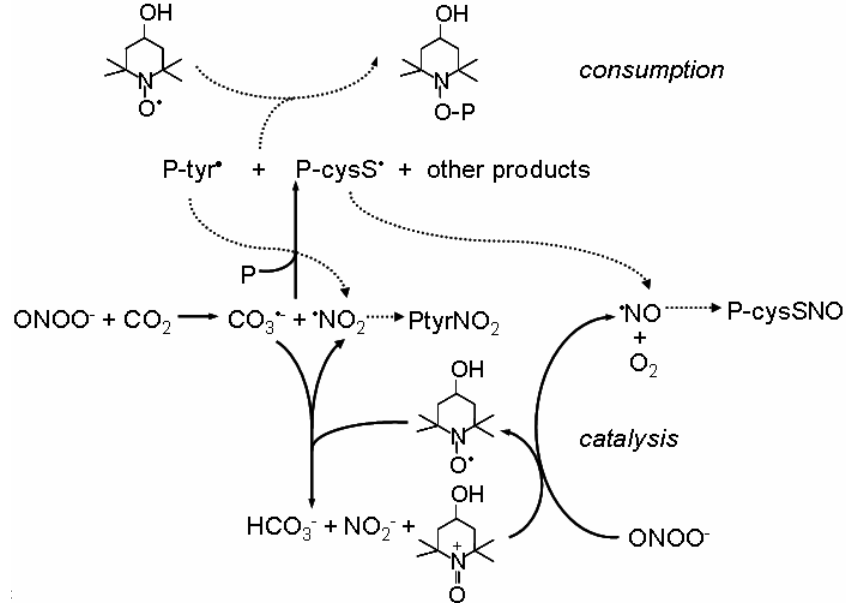
Fig. 2 – Schematic representation of the mechanism by which tempol shifts peroxynitrite reactivity towards proteins from nitration to nitrosation. P represents a generic protein. The reactions are not balanced and the scheme summarizes the known reactions of tempol with peroxynitrite/carbon dioxide-derived radicals and the main reactions of proteins with nitrogen dioxide and carbonate radicals (shown by solid arrows). The recombination reactions that produce PtyrNO 2 and PcysNO and those that consume tempol precluding its continuous recycling are also shown by dashed arrows (Fernandes et al. 2005, Vaz and Augusto